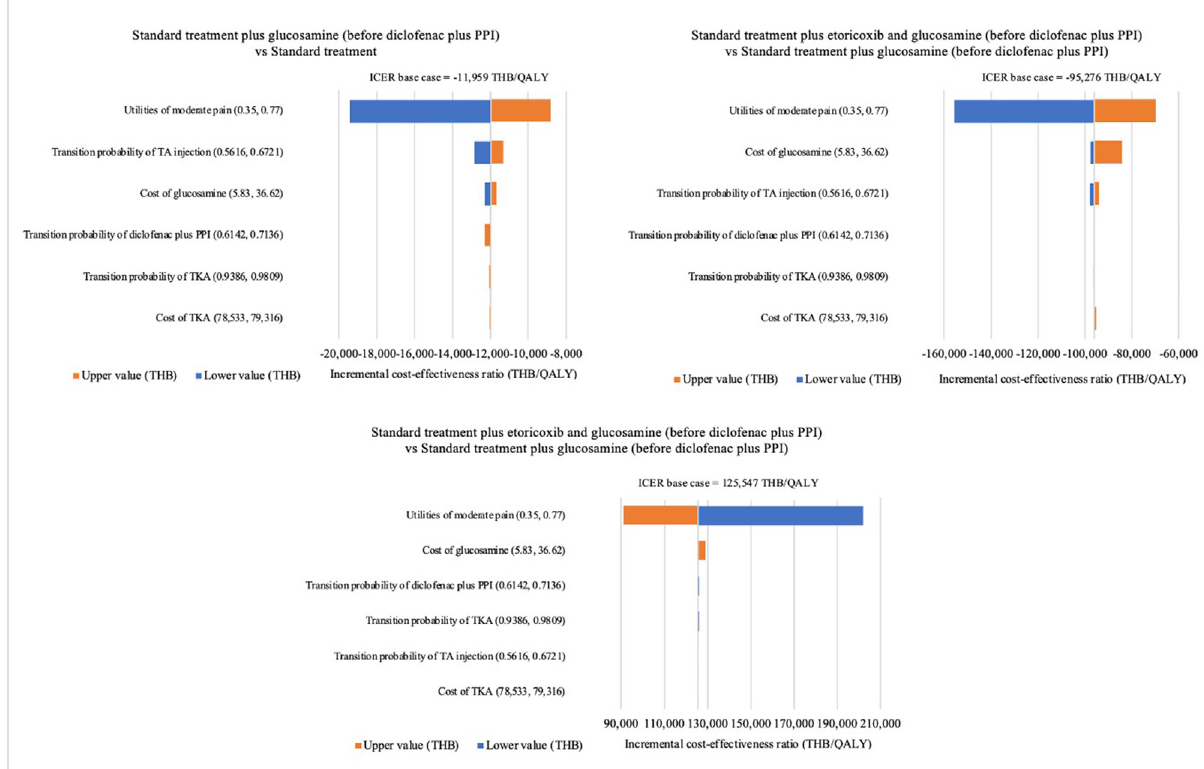
FIGURE 2 Tornado diagram. PPI, proton pump inhibitors; TA, triamcinolone acetonide; TKA, total knee arthroplasty; QALYs, quality-adjusted life-years; THB, Thai